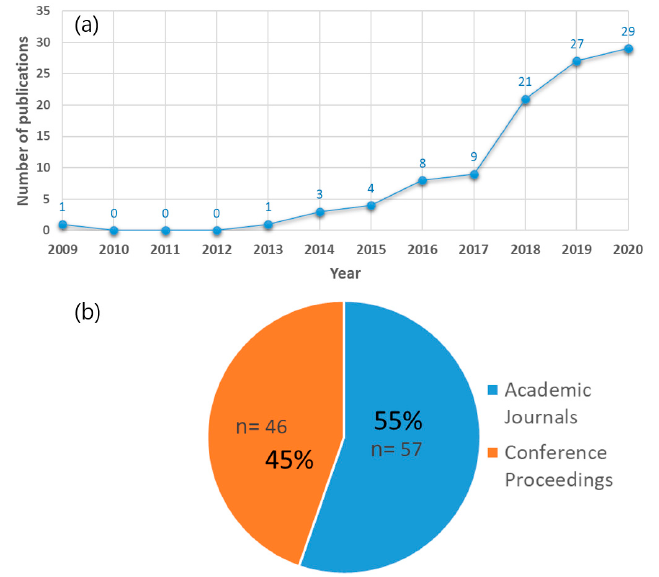
Figure 2. Number of publications related to smart helmet research by ( a ) year and ( b ) source of publications.